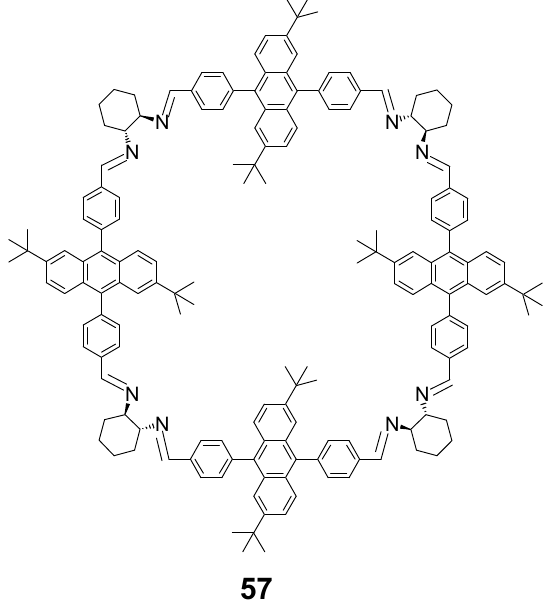
Figure 24. Giant [4 + 4] macrocycle 57 obtained in p -xylene-templated reaction. A tetranuclear zinc(II) complex of [4 + 4] macrocycle 58 (Figure 25) can be obtained in a template reaction by using the same enantiopure DACH, the same aldehyde